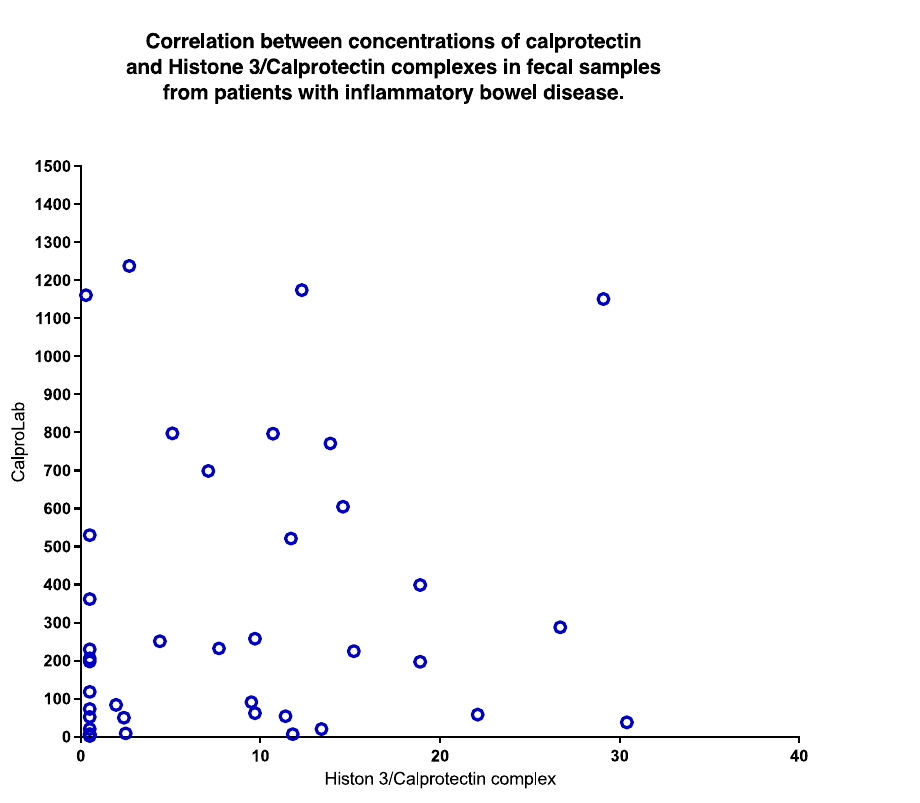
Figure 9. A plot of concentrations of CP and NETs in stools from IBD patients shows a non-significant correlation. High values of CP occurred despite low levels of NETs and vice versa.